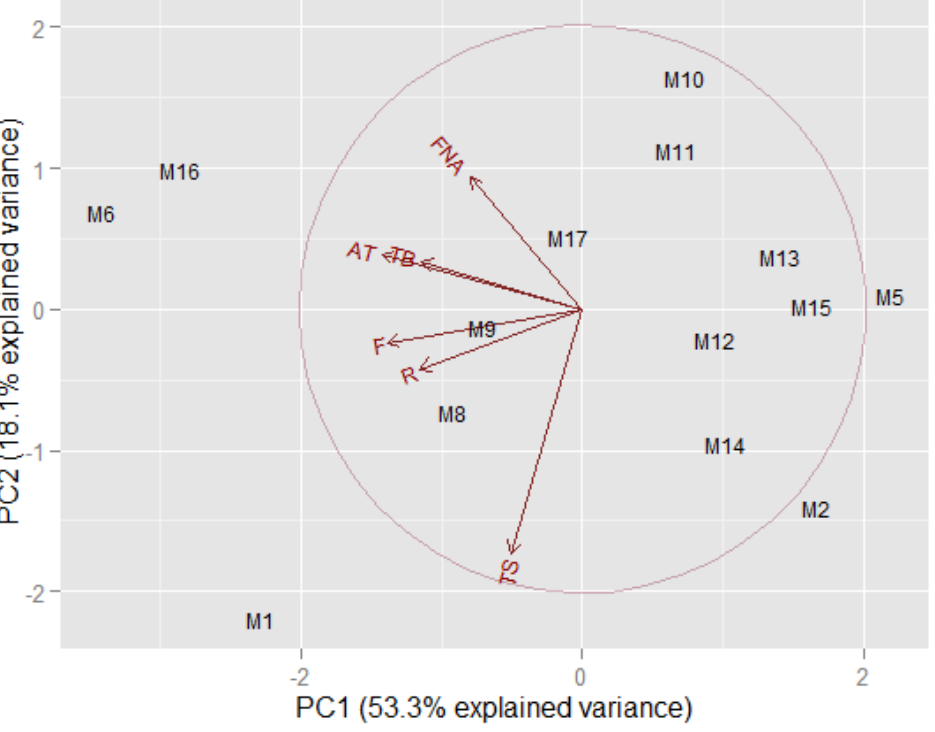
Figure 1. Principal Component Analysis (PCA) biplot. Codes: Total anthocyanins (AT), Total flavonoids (TF), Flavonoids other than anthocyanins (FNA), Total flavonoids in seeds (TS), Resveratrol (R) and Flavonols (F).